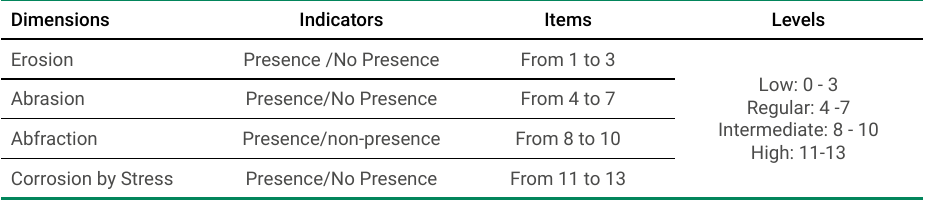
Table 2. Operational definition of variable non-carious cervical lesions.